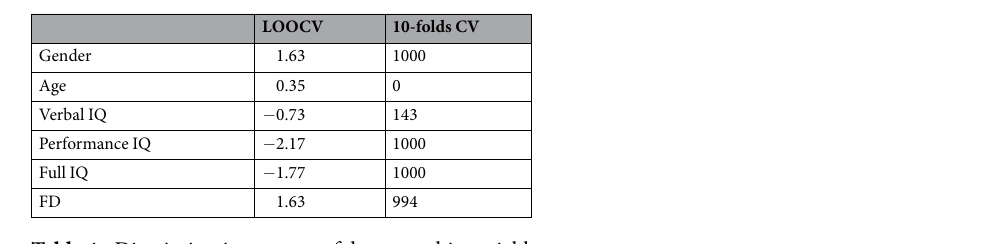
Table 4. Discriminative powers of demographic